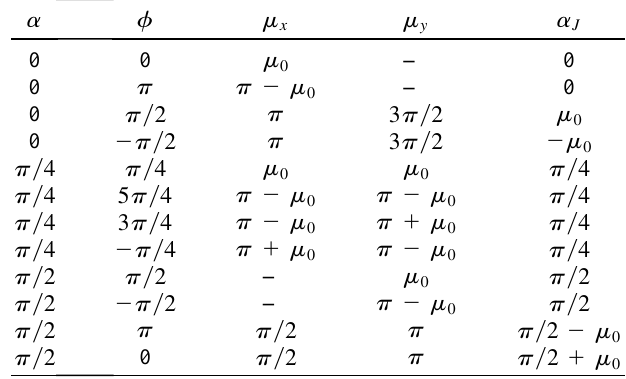
(cid:173) (cid:110) (cid:50) 1 (cid:75) (cid:50) . We used the collimator apertures (cid:110) (cid:49) (cid:173) (cid:54) and (cid:49) max max